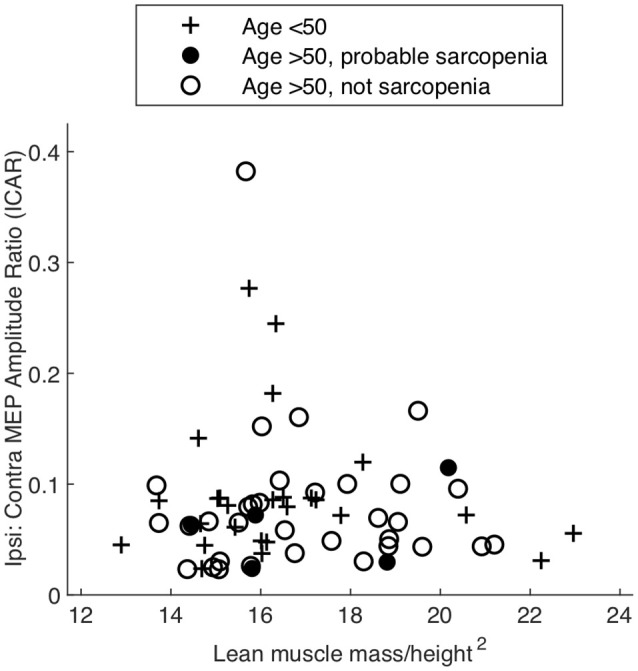
Amplitude ratio (ICAR) compared to a measure of muscularity (lean muscle/height2) in different age groups and sarcopenia.